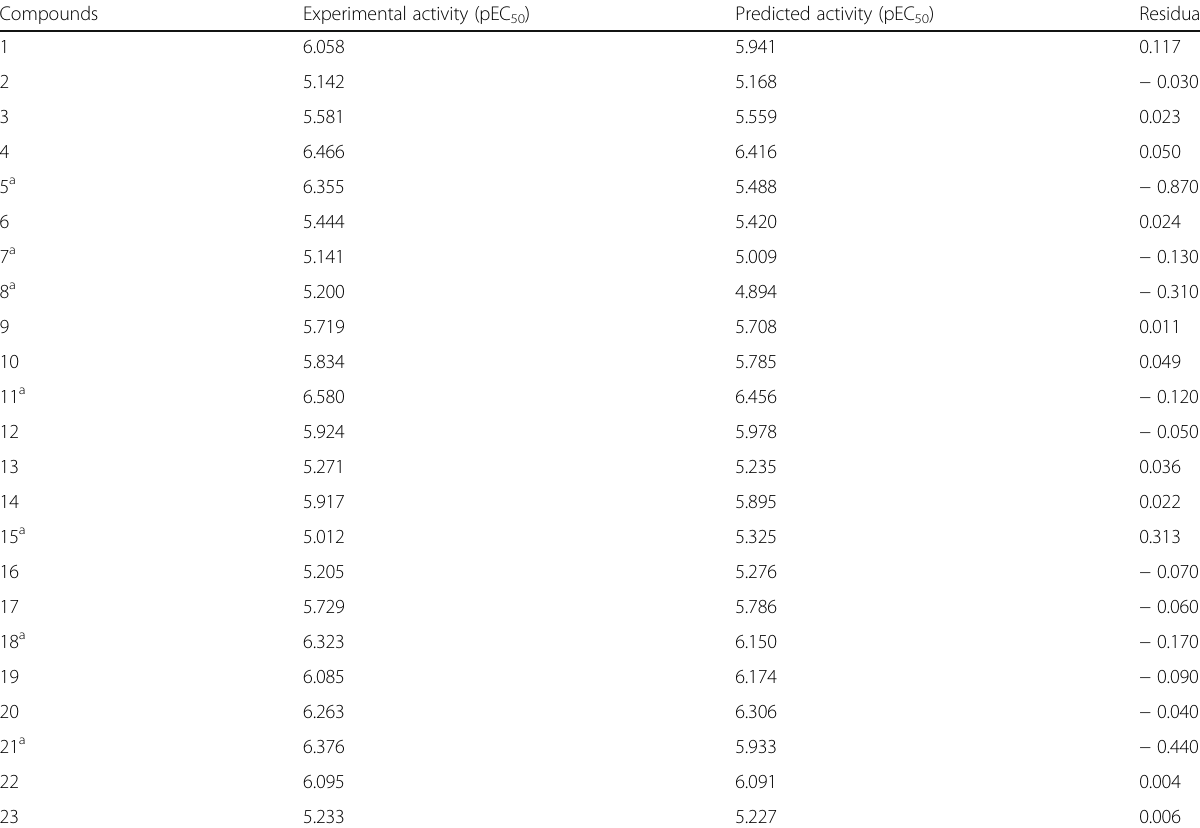
Table 3 Experimental and predicted activities for the compounds with residual Compounds Experimental activity (pEC 50 ) Predicted activity (pEC 50 ) Residual